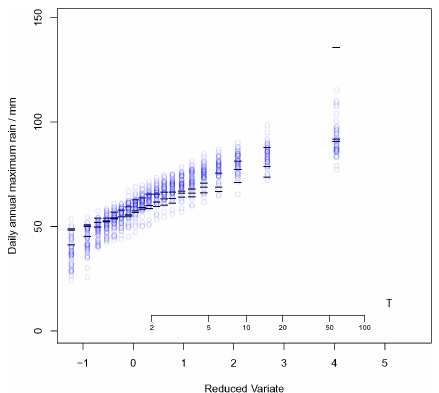
Fig. 7. Median annual maxima of sites in the central region. The ob- served ( − ) consists of three samples of 20yr. The simulated (blue circles) are based on 50 samples of 20yr (1000yr of simulated data).